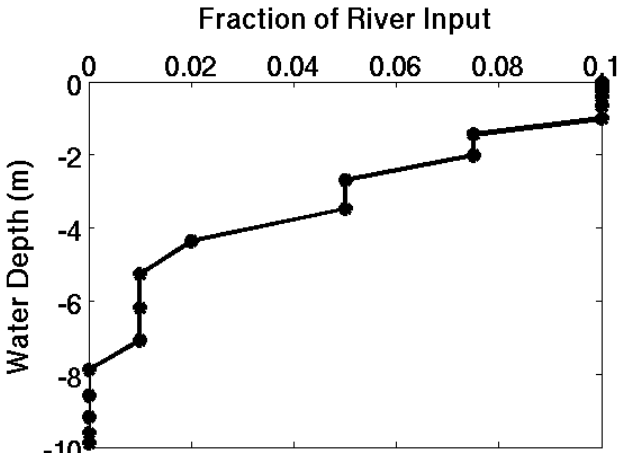
Figure 5. Vertical profile of river input showing the partitioning of momentum, fresh water, and river sediment at the river